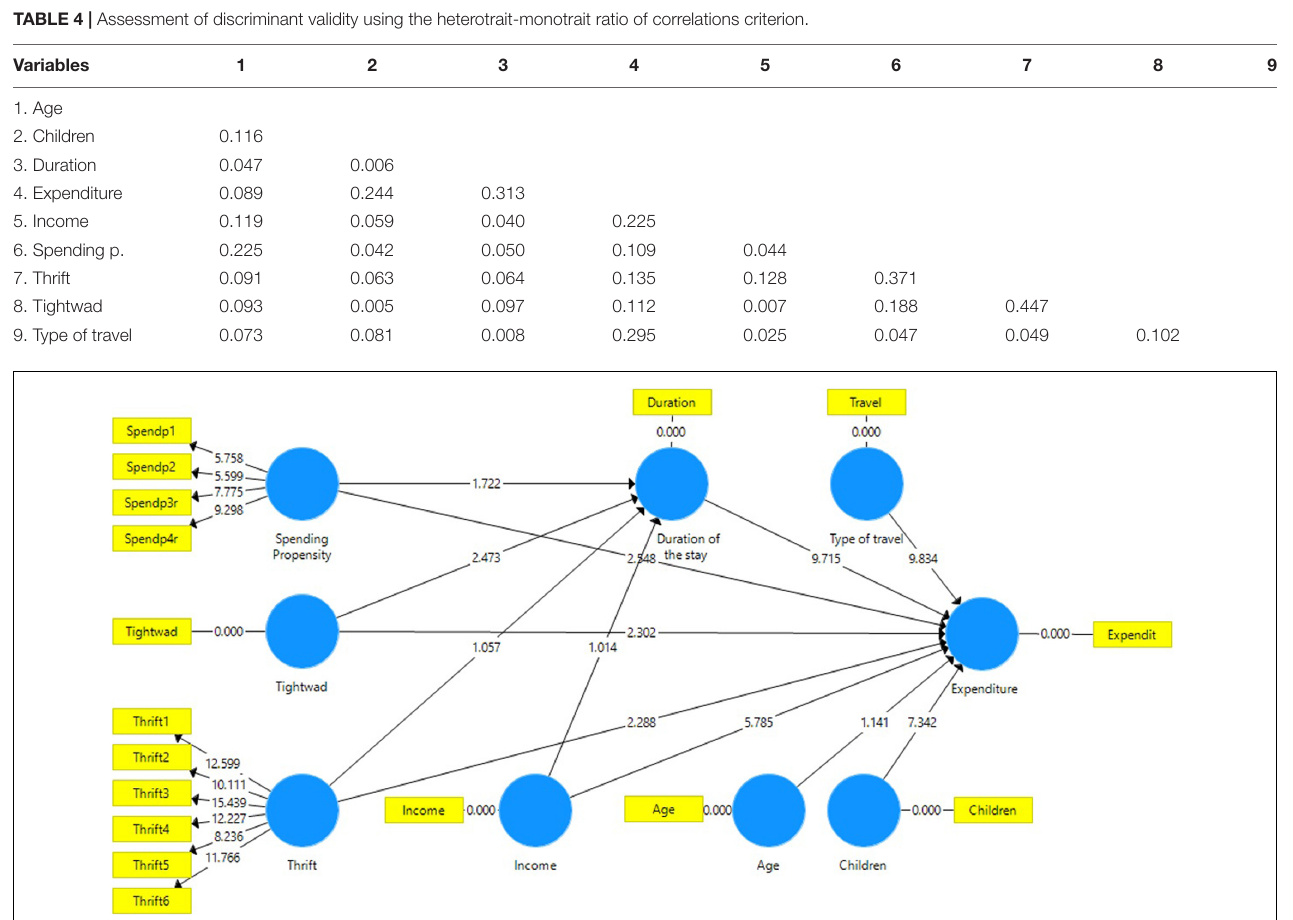
FIGURE 3 | Tested model and the estimation. Bootstrap t-statistics based on 820 cases and 5,000 replications.